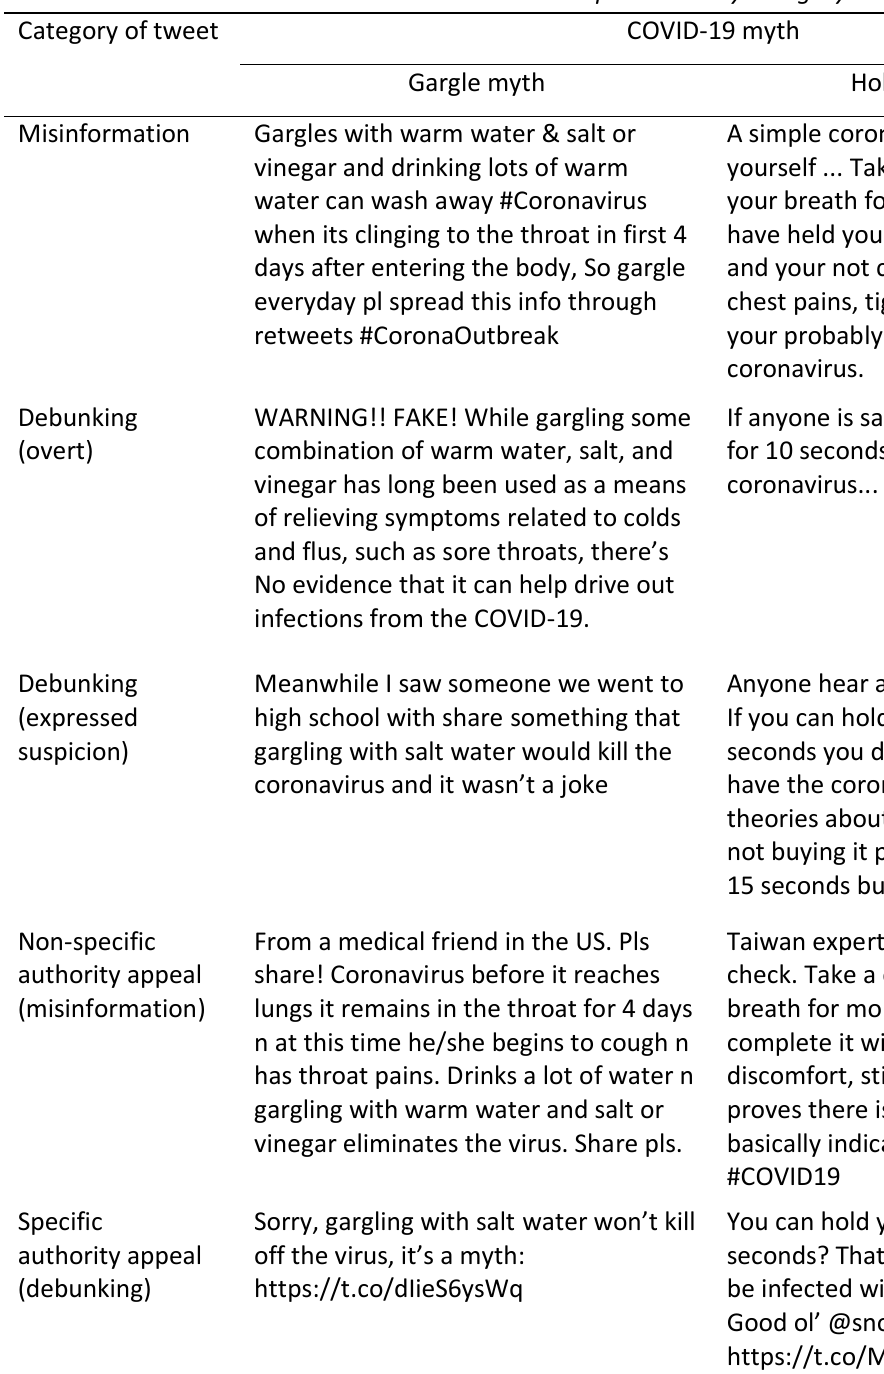
Table 3 . COVID-19 example tweets by